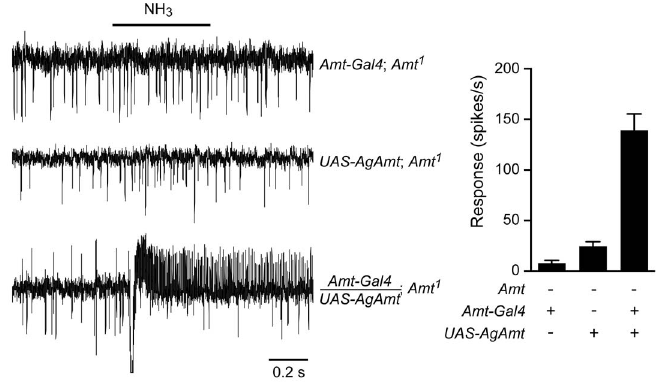
Figure 8. AgAmt from the mosquito Anophelesgambiae can substitute for DrosophilaAmt. Traces on the left show that the lack of response to a 500 ms puff of 0.1% ammonia in Amt 1 mutant flies was restored by transgenic expression of AgAmt (n=8 each, p , 0.0001). Mean responses are shown in the graph on the right. Data for Amt-GAL4; Amt 1 are from Figure 6C.